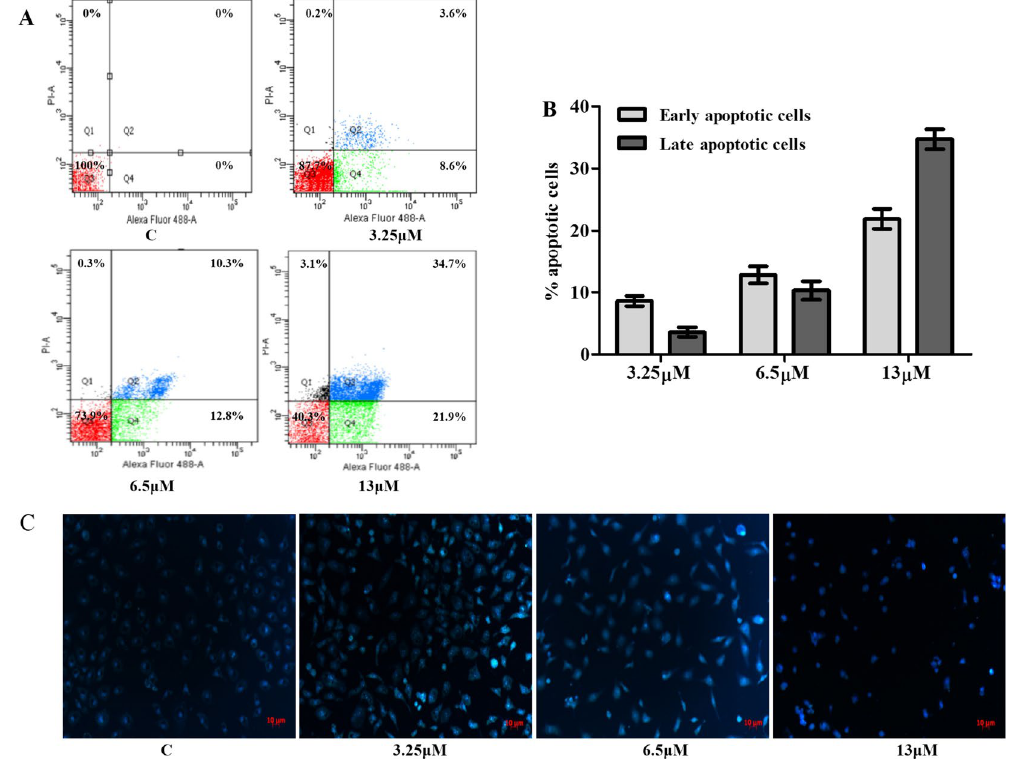
Figure 4. Detection of apoptosis induced by M22 by flow cytometry and confocal microscopy. ( A ) Evaluation of apoptosis by Annexin V/PI dual staining assay. Numbers of Annexin V-and PI-positive cells were determined using flow cytometry. Quadrant 1: necrotic cells; Quadrant 2: late-apoptotic cells; Quadrant 3: viable cells; Quadrant 4: early apoptotic cells. ( B ) The percent of apoptotic cells are represented by bar diagram. ( C